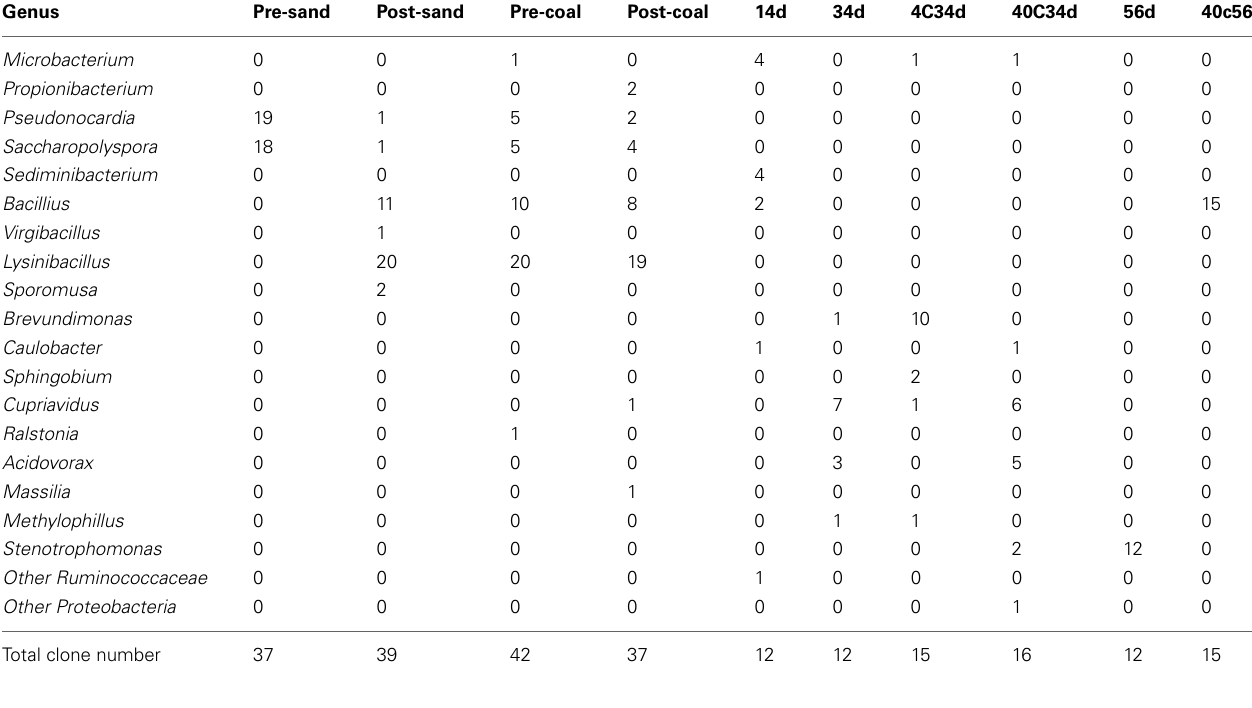
Table 4 | Results of cloning analysis of bacteria in samples pre-sand, post-sand, pre-coal, post-coal, 14d, 34d, 4C34d, 40C34d, 56d, and 40C56d. Genus Pre-sand Post-sand